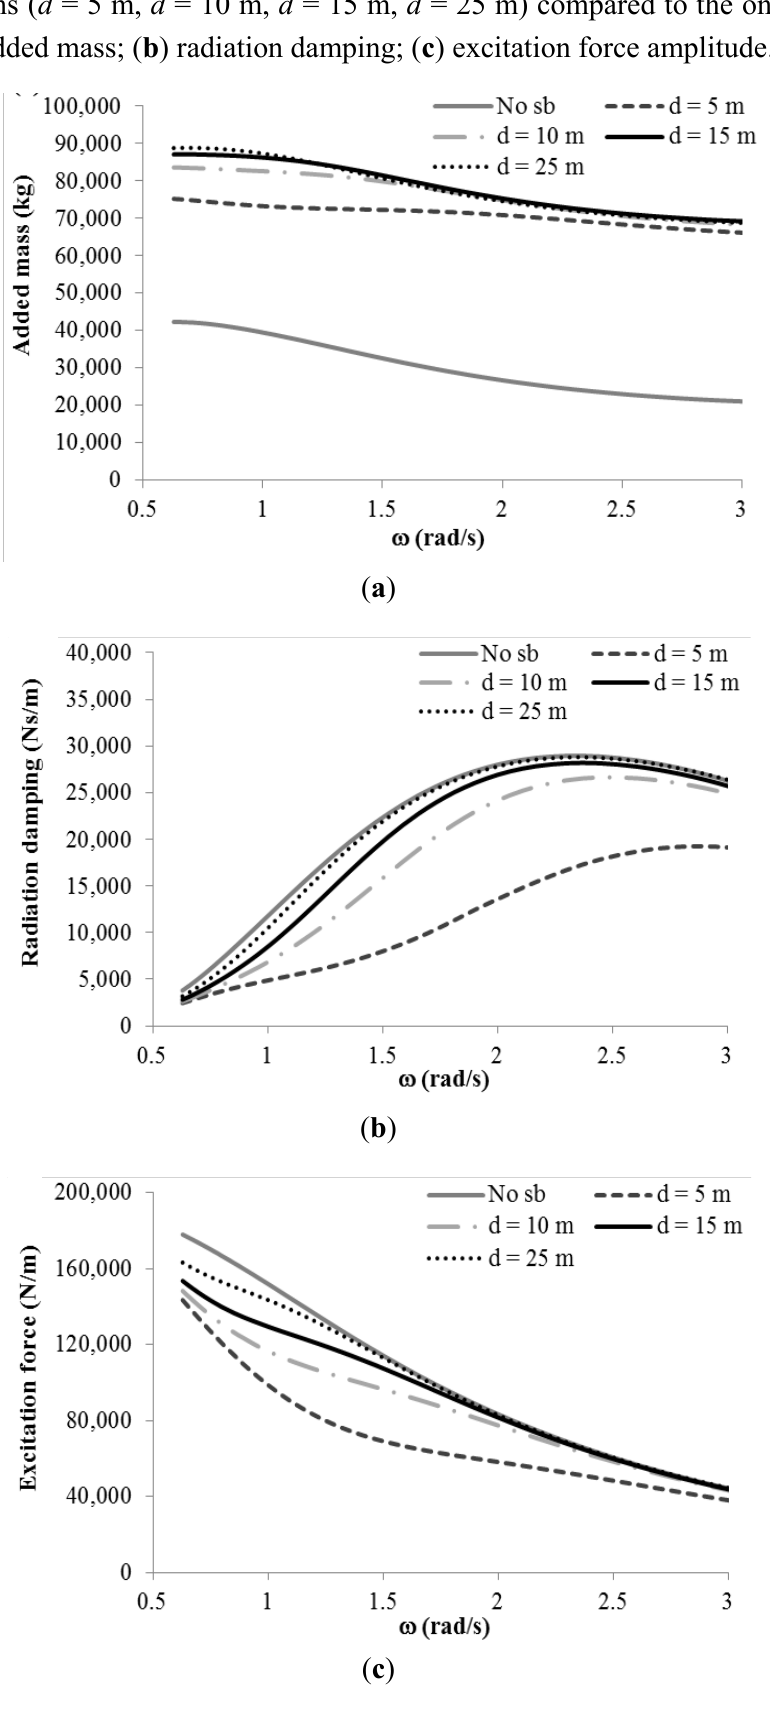
Figure 4. Hydrodynamic parameters of Buoy 2sb calculated with the submerged body at different depths ( d = 5 m, d = 10 m, d = 15 m, d = 25 m) compared to the ones of Buoy